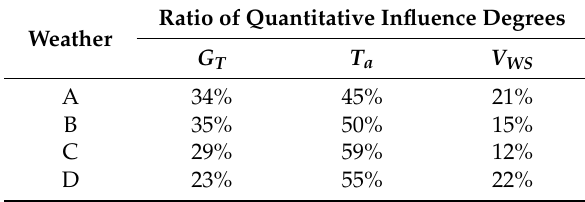
Table 10. Ratio of quantitative influence degrees measured by